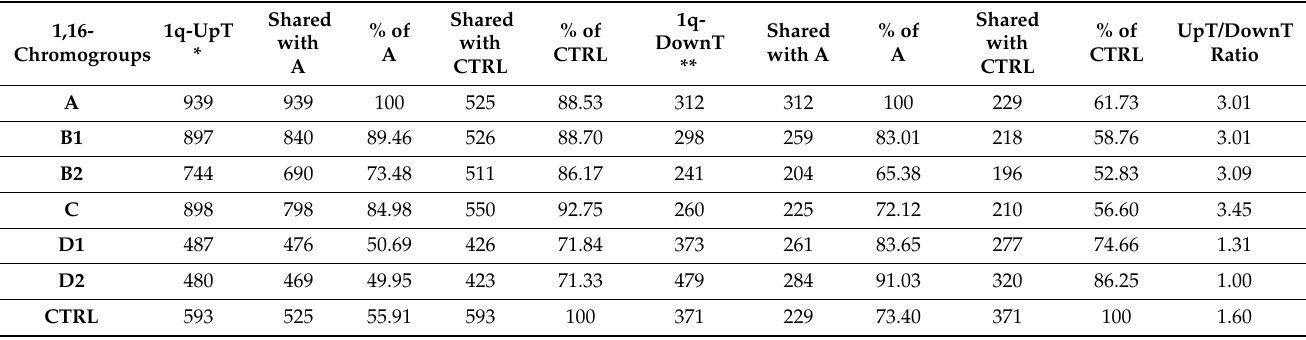
Table 3. Number of 1q- and 16q-UpT (Upregulated Transcripts) and 1q and 16q-DownT (Downregulated Transcripts) in